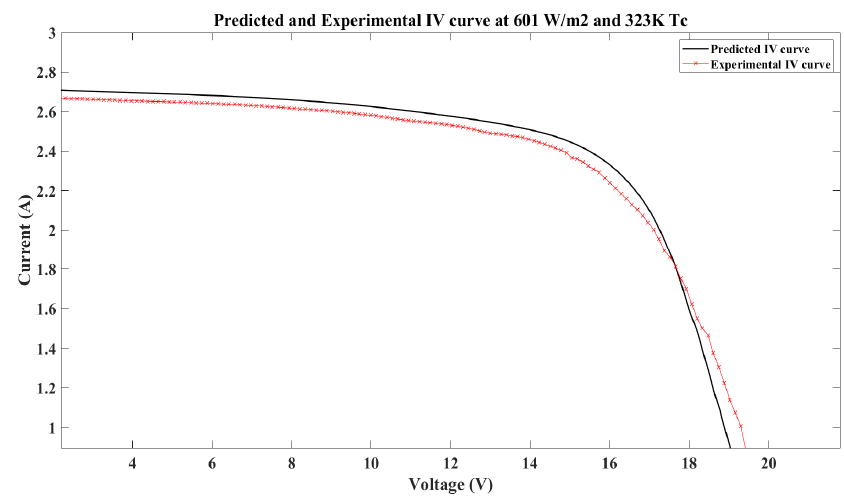
Figure 7. Predicted and experimental IV curves for CIGS module at 601 W/m 2 and 323K Tc.